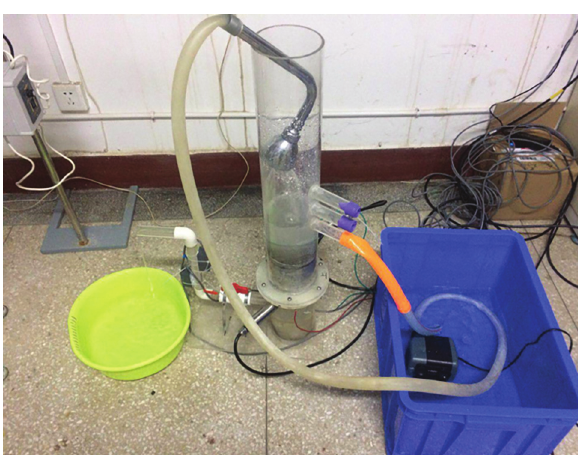
Figure 2: Test actual operation diagram.